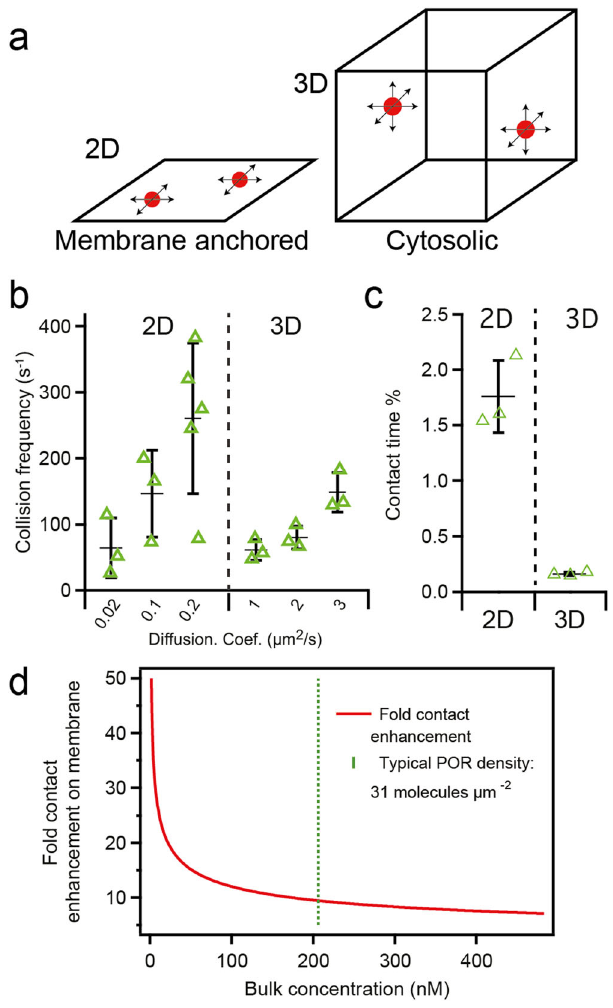
Fig. 4 Membrane anchoring drives intermolecular interactions. a Stochastic diffusion simulation system with two particles con fi ned to two- or three dimensions. In both cases, the side of the simulation box is L = 0.25 µ m (corresponding to a membrane density of 31 molecules/ µ m 2 and 206 nM, respectively), the box harbor two spherical particles with radius R = 10 nm. Time increments in the stochastic simulation were 10 µ s and each simulation run was 750 ms. The two molecules were counted as being in contact when the center-to-center distance was ≤ 20 nm which is approximately the dimension of a putative POR dimer 20,34 . b Collision frequency for an array of typical diffusion coef fi cients comparing two- and three-dimensional diffusion. Each bar provides the average ± s.d. of n = 3 simulation runs, except n = 5 for D = 0.2 µ m 2 /s. c Contact time of the two particles in two- and three dimensions (reported as % of time in contact relative to the full simulation time). Bars provide the average ± s.d of colocalization calculated for the 3 diffusion coef fi cient bins in ( b ) for the respective dimensionality. d Contact enhancement upon membrane grafting as a function of particle concentration in bulk. See Supplementary Note 3. Source Data are available in Supplementary Data